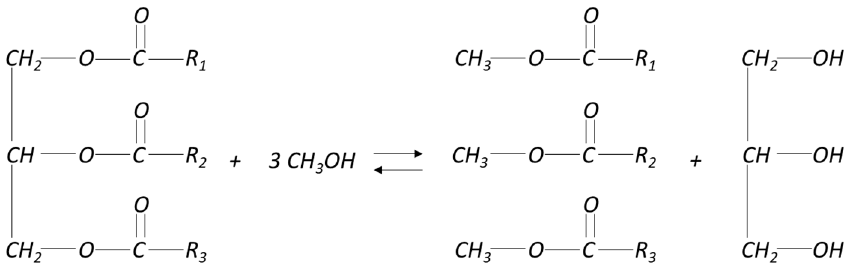
Figure 1. Transesterification reaction of fatty acids for the production of biodiesel. (R 1 , R 2 , and R 3 are hydrocarbons chains containing 15–21 C atoms